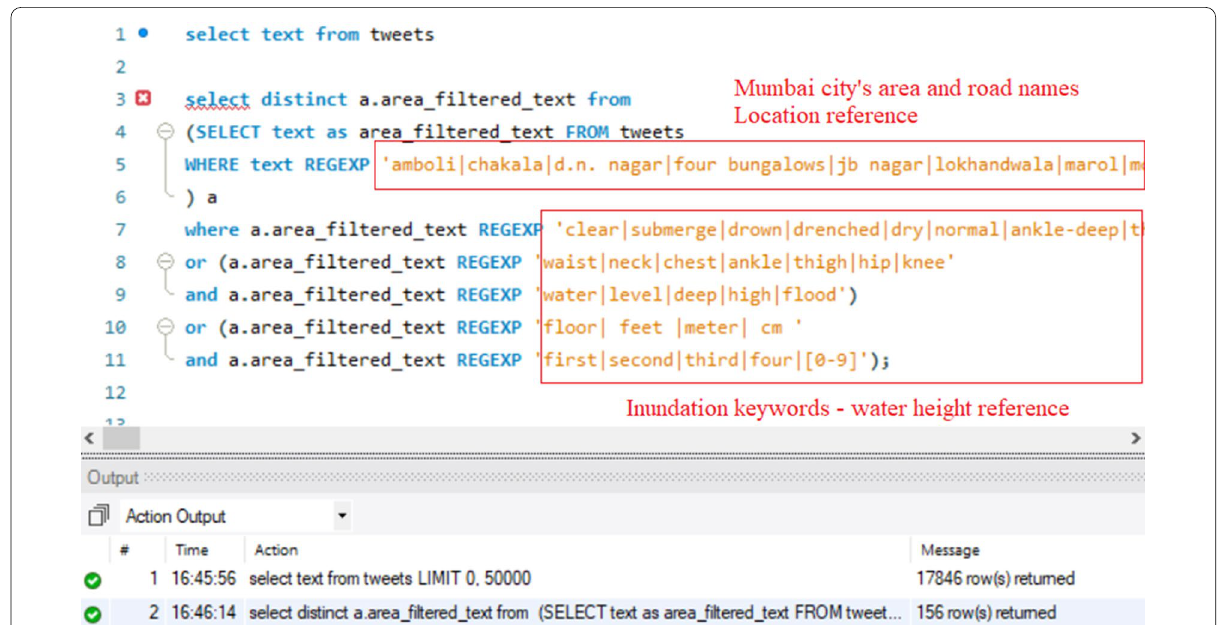
Fig. 7 MySQL Workbench—Keyword based query and results (screen